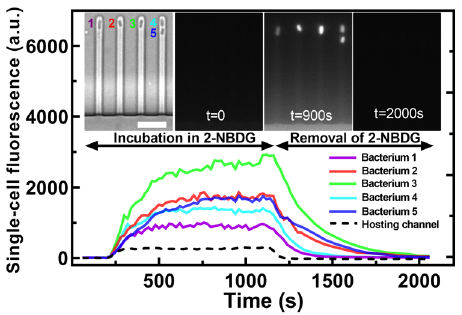
in individual bacteria. Temporal dependence of the intracellular fl uorescence of the glucose analogue 2-NBDG in fi ve representative E. coli cells con fi ned in the bacterial hosting channels of the micro fl uidic mother machine. The dashed line represents the fl uorescence of the extracellular 2-NBDG in the bacterial hosting channels. Noteworthy, we measured 2-NBDG fl uorescence as the mean fl uorescent values of each pixel constituting each bacterium, thus normalizing by cell size. Insets from left to right: bright fi eld image of the fi ve bacteria at t = 0s when the fl uorescent glucose analogue is added to the mother machine; corresponding image in the green fl uorescent channel; saturation of 2-NBDG intracellular fl uorescence levels at t = 900s followed by removal of extracellular 2-NBDG at t = 1200s; complete degradation of intracellular 2-NBDG leading to intracellular fl uorescence down to background levels by t = 2000 s. Scale bar: 5 µ